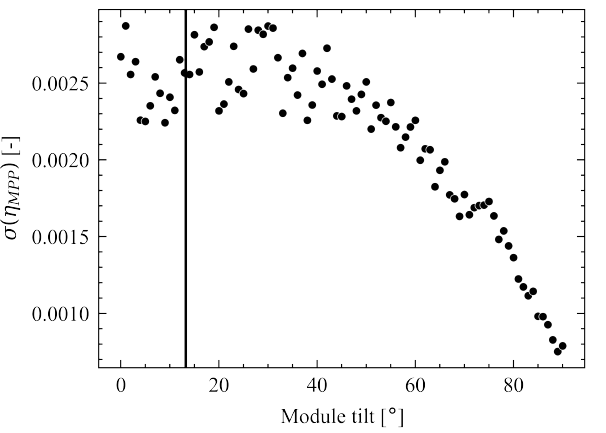
Figure 5. Impact of the module tilt on the daily efficiency for one randomly selected day. For the studied location, the optimal tilt angle is 13.23°, marked with the vertical